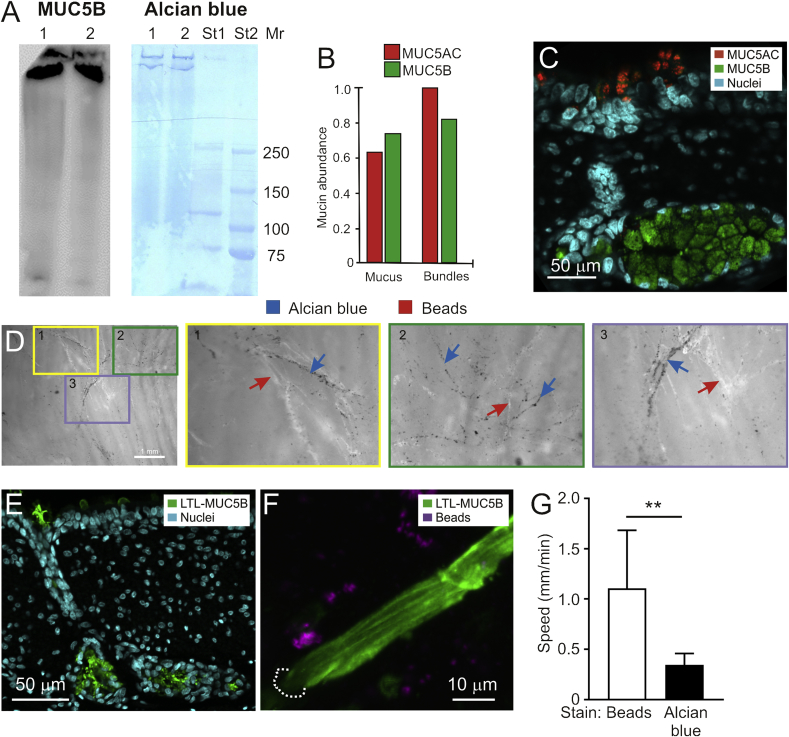
The piglet MUC5B mucin bundles are stained by Alcian blue but not fluorescent beads. A. SDS-PAGE and Western blot stained with anti-MUC5B (left) and gel directly stained with Alcian blue (right). Lane 1 and 2 were loaded with gently scraped mucus from piglet trachea. Protein standards (St1, St2) with molecular mass (Mr, kDa) of St2. Representative of three repeats. B. Relative abundance of MUC5AC and MUC5B in mucus and bundles by targeted proteomics and relative to MUC5AC in bundles. C. Immunofluorescence of pig trachea. MUC5AC in the surface goblet cells (red) and MUC5B in the submucosal gland (green). D. Mounted piglet tracheas stained with Alcian blue and 40 nm fluorescent beads. Three colored areas were magnified. The 40 nm fluorescent beads (white material, marked with red arrows) do not stain the same structures as Alcian blue (black material, marked by blue arrows). Identical results were obtained for 10 pigs. E. LTL lectin (green) stains submucosal gland mucins (MUC5B). F. Live trachea with mucus bundles stained with the LTL lectin for MUC5B (green) and added 40 nm fluorescent beads (purple) showing little colocalization. The experiment was repeated 3 times. G. The mean speed of mucus bundles stained with Alcian blue or 40 nm fluorescent beads, n = 8, **p = 0.002.